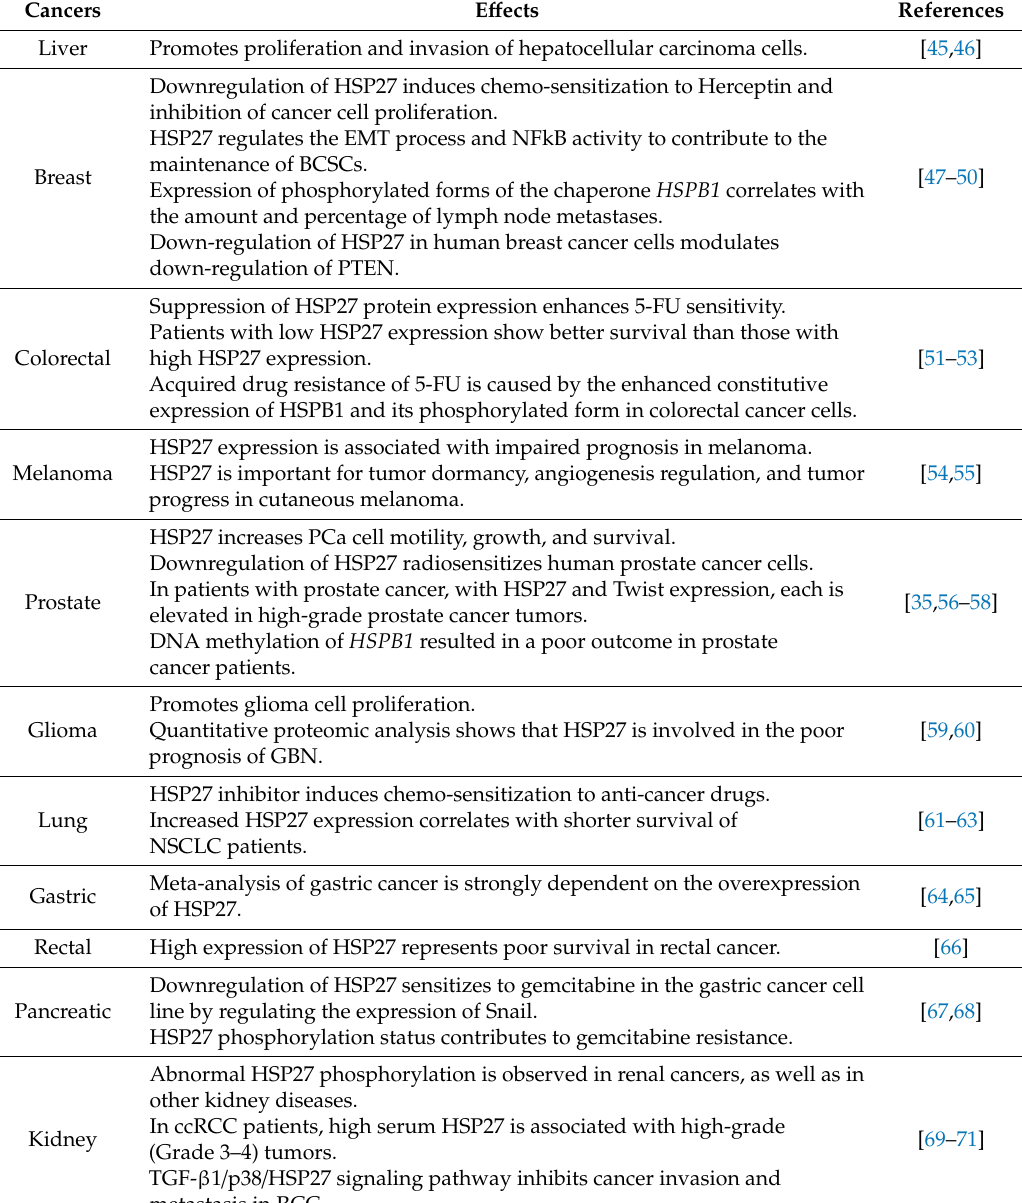
Table 1. Functions of heat shock protein 27 (HSP27) in various cancer cells (year 2010~).